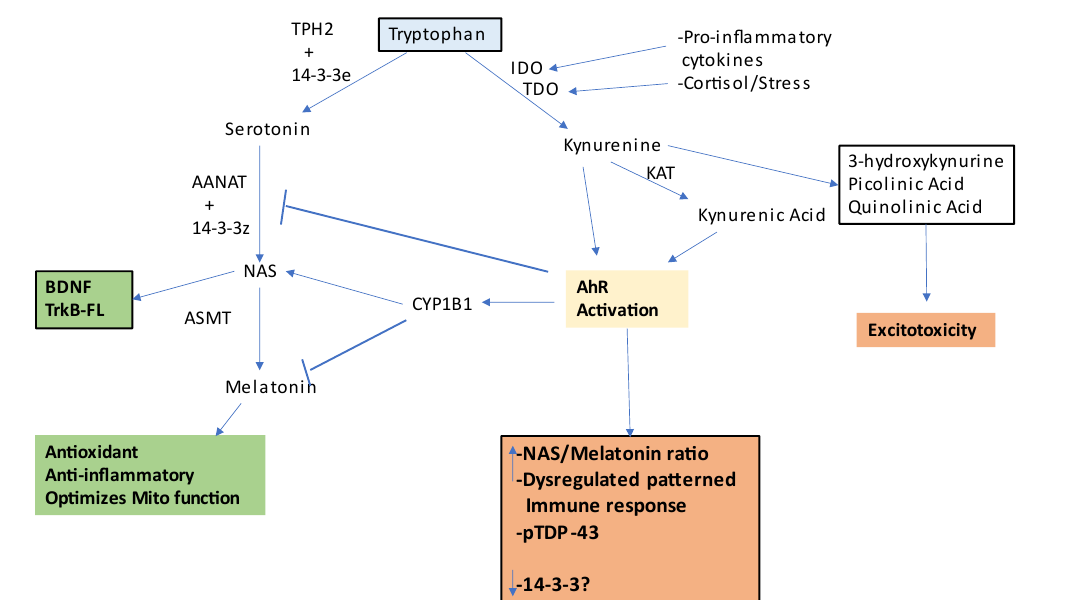
Figure 1. This figure shows how tryptophan (light blue shade) can be utilized for beneficial (green) or detrimental (orange) effects in ALS. Tryptophan is converted to serotonin in astrocytes by tryptophan hydroxylase (TPH)2 which has been stabilized by 14-3-3e. Serotonin is converted by AANAT to N-acetylserotonin (NAS) when stabilized by another 14-3-3 isoform and in the presence of acetyl-CoA as a co-substrate. NAS is converted by ASMT to melatonin. NAS can activate the BDNF receptor, TrkB, as well as induce BDNF, whilst melatonin has antioxidant, anti-inflammatory, and mitochondria- optimizing effects. However, in the presence of pro-inflammatory cytokines and stress-associated cortisol-induced IDO and TDO, respectively, tryptophan is converted to kynurenine, which can activate the AhR leading to a number of detrimental effects via kynurenine pathway products that drive excitotoxicity. However, when an active melatonergic pathway is present, AhR-induced CYP1B1 can ‘backward’ convert melatonin to NAS, thereby increasing TrkB-FL activation and BDNF induction. Abbreviations: AANAT: aralkylamine N-acetyltransferase; AhR: aryl hydro-